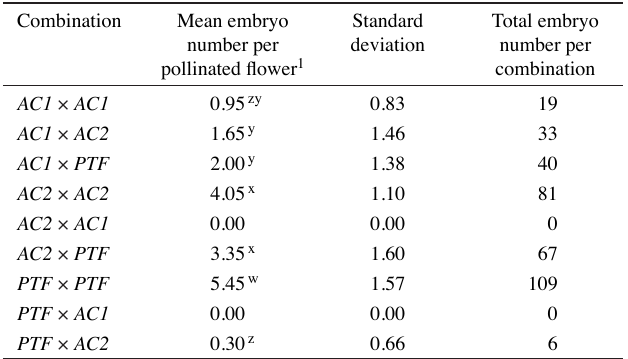
Tab. 4: Influence of the combination on the number of embryos, two weeks after